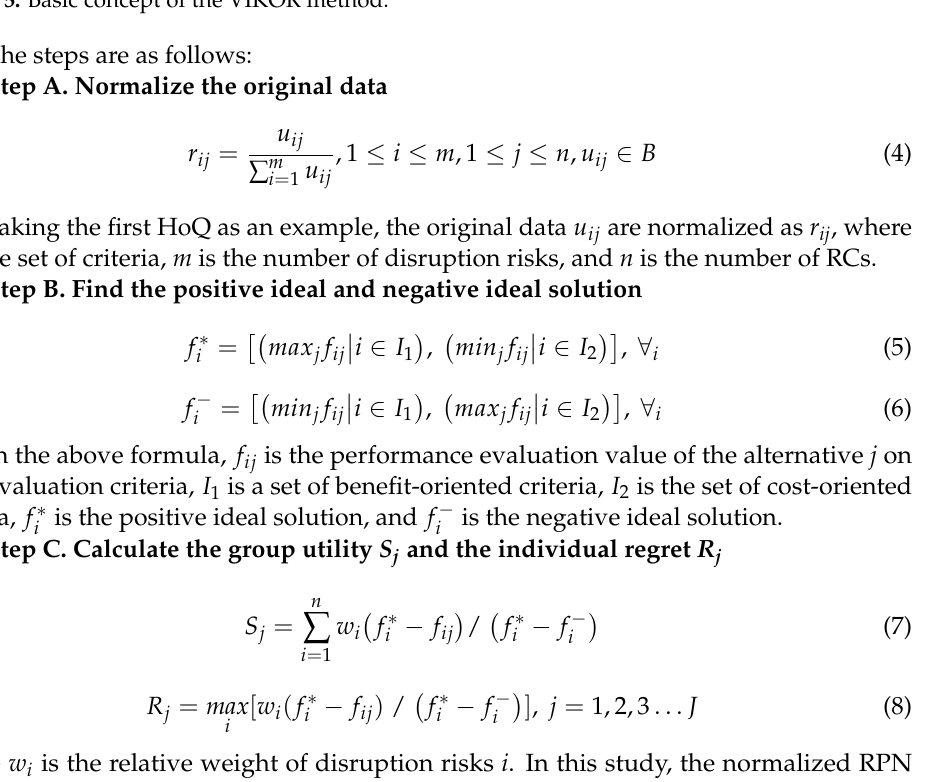
Figure 5. Basic concept of the VIKOR method.